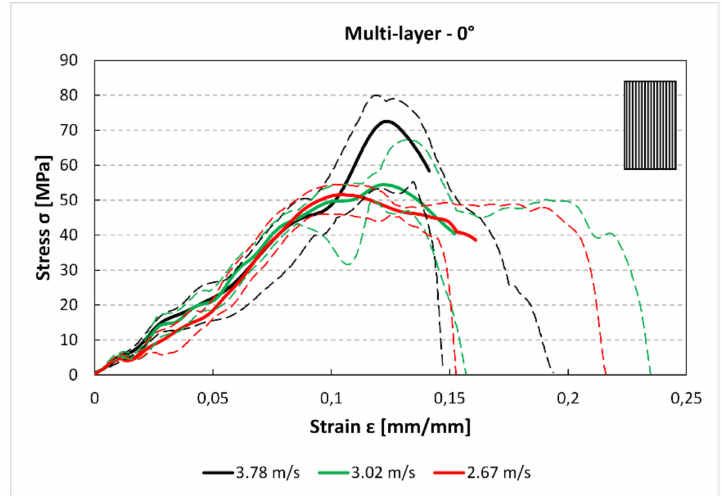
Figure 12. Multilayer stress–strain curves for 0 ◦ specimens and for each impact